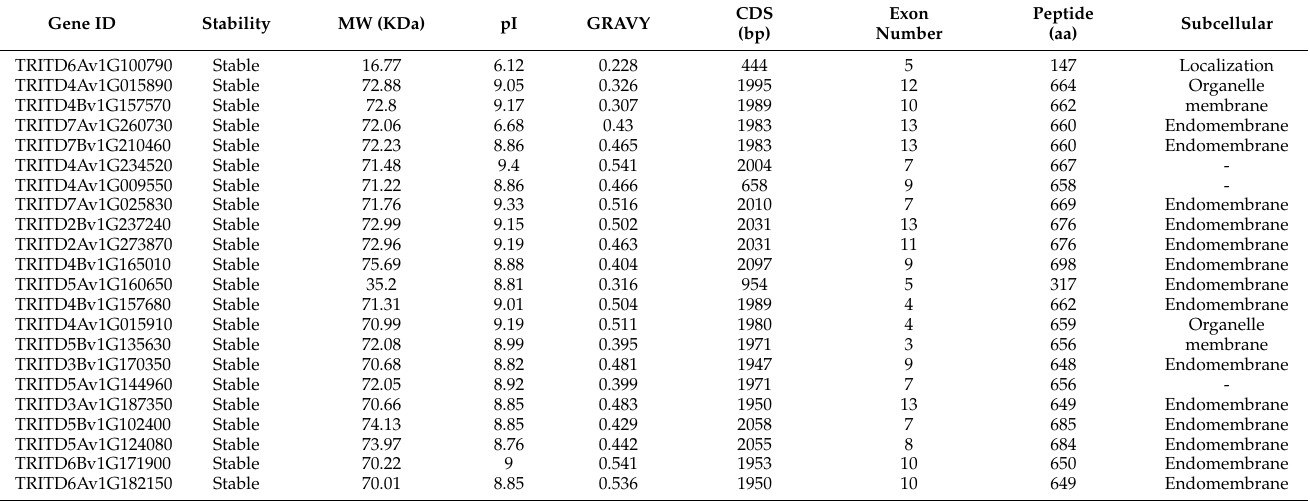
Table 1. Physicochemical properties for Td SULTR family members within the T. turgidum L. ssp. durum (Desf.)